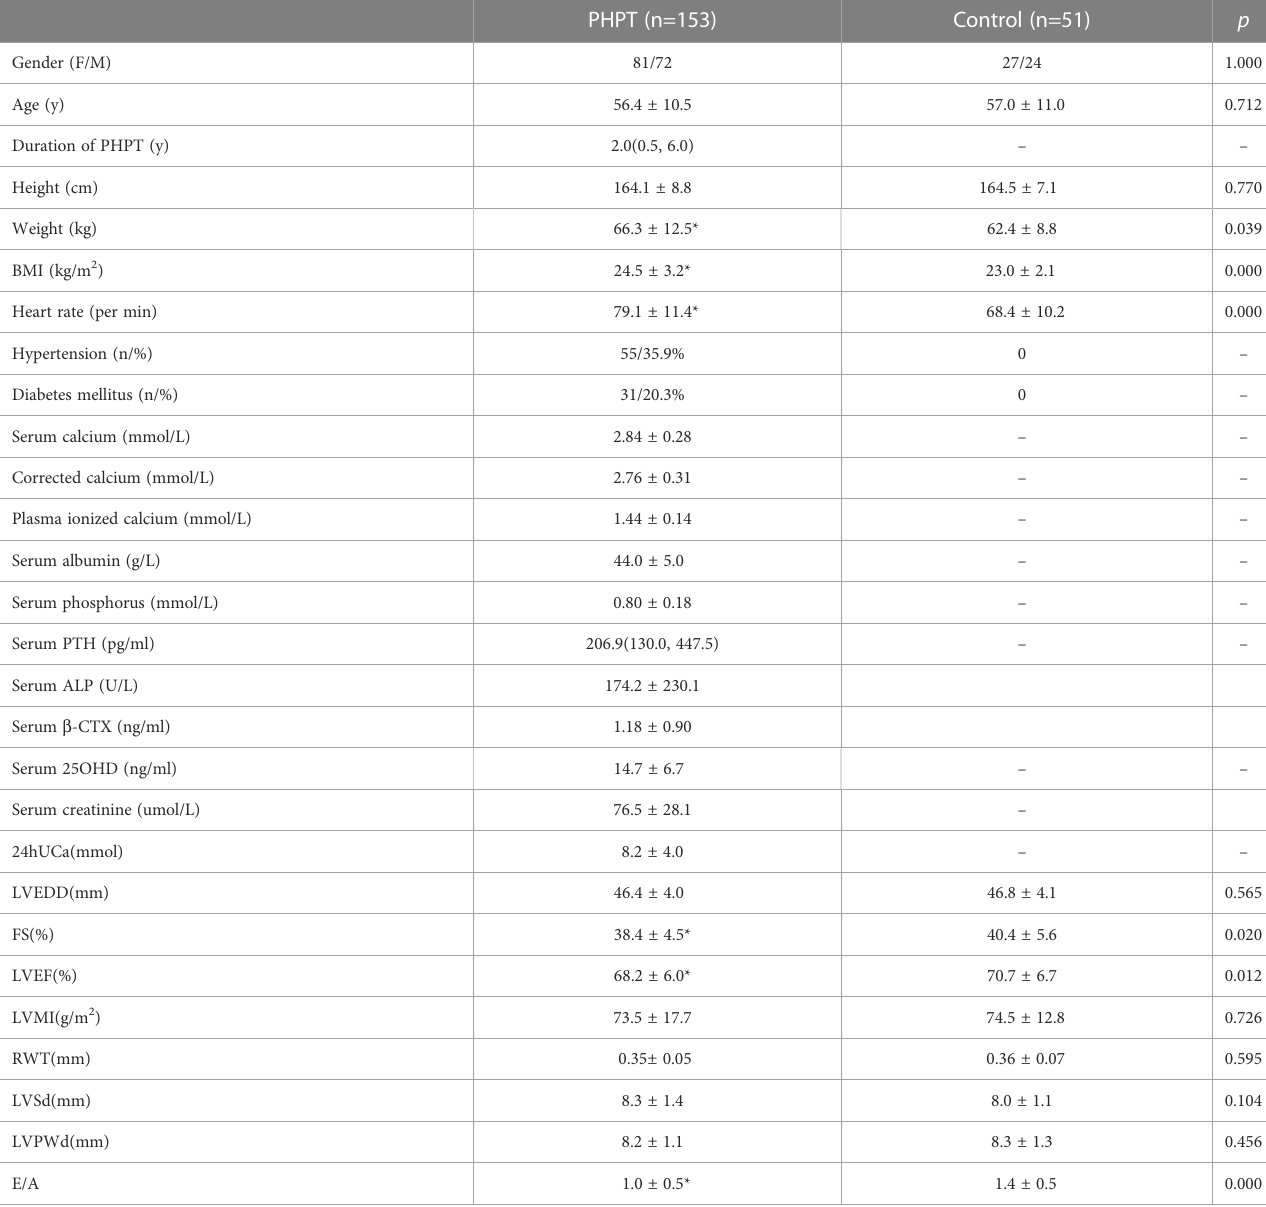
TABLE 1 Demographical, physical examination, and echocardiographic parameters in PHPT and healthy control